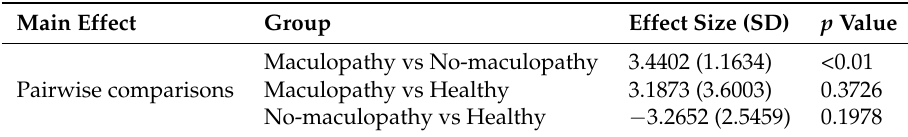
Table 5. Main effect for diagnosis using the SLME